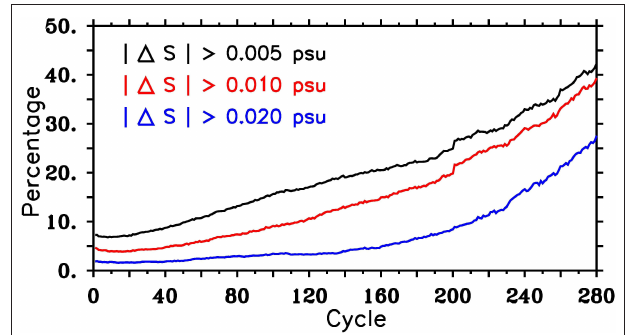
FIGURE 10 | Percentage of salinity adjustments vs. the number of cycles, from 10,048 Argo floats.